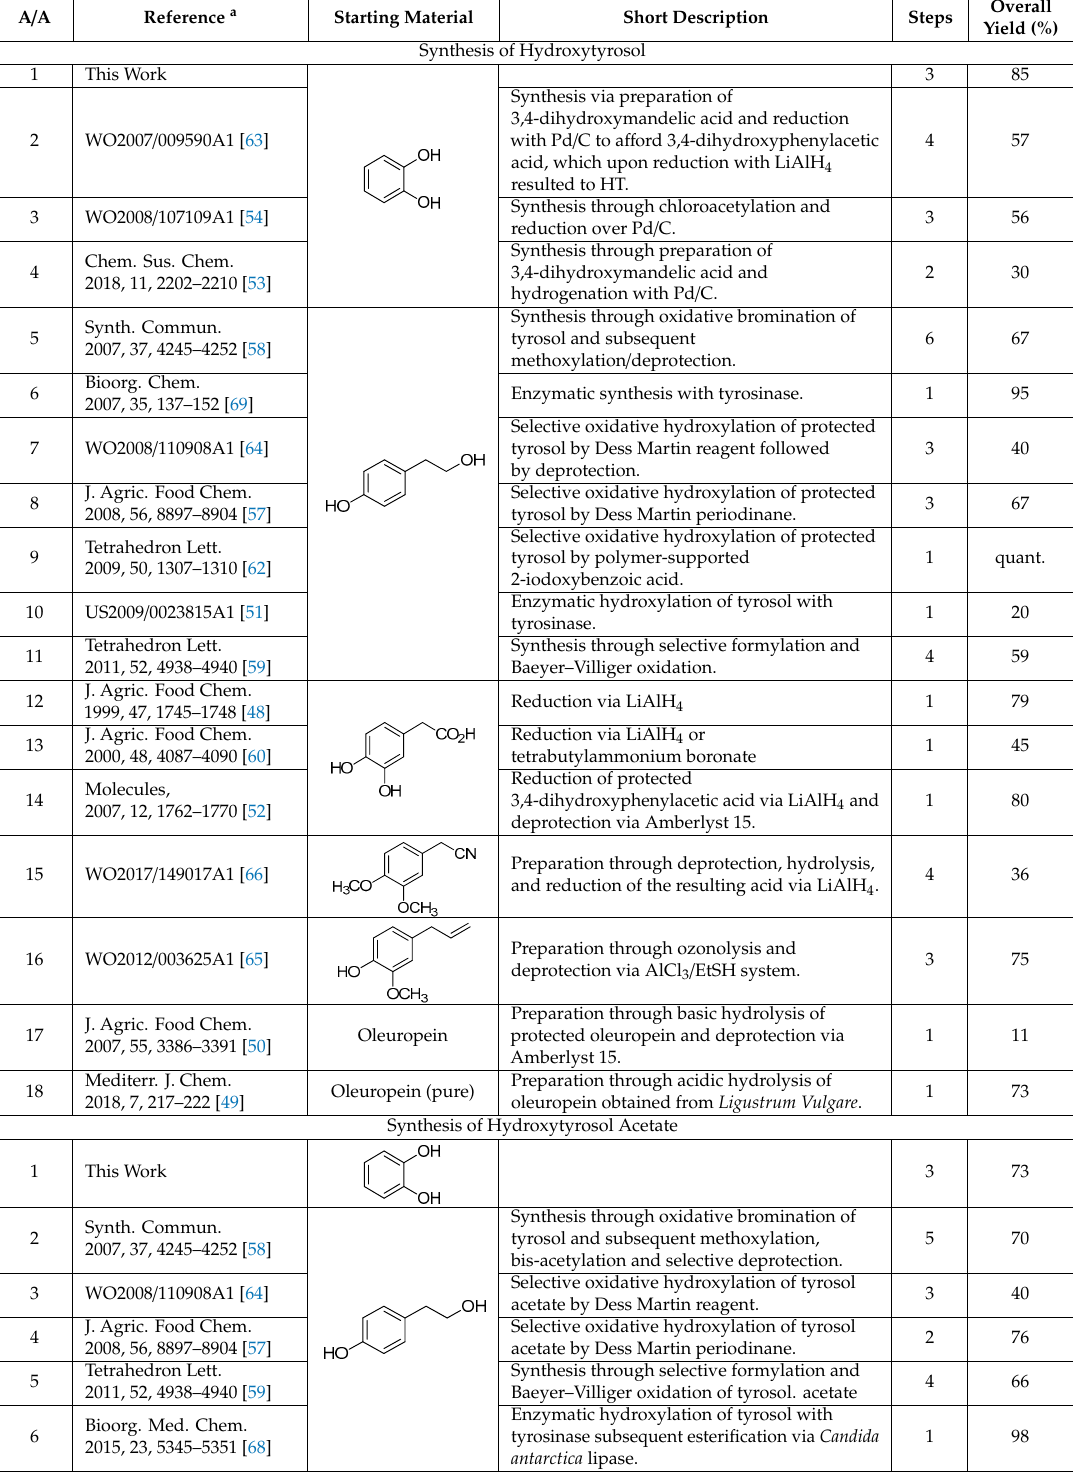
Table 1. Comparison of the methodologies for the preparation of hydroxytyrosol (HT), HT Acetate and 3,4-dihydroxyphenylglycol (DHPG).